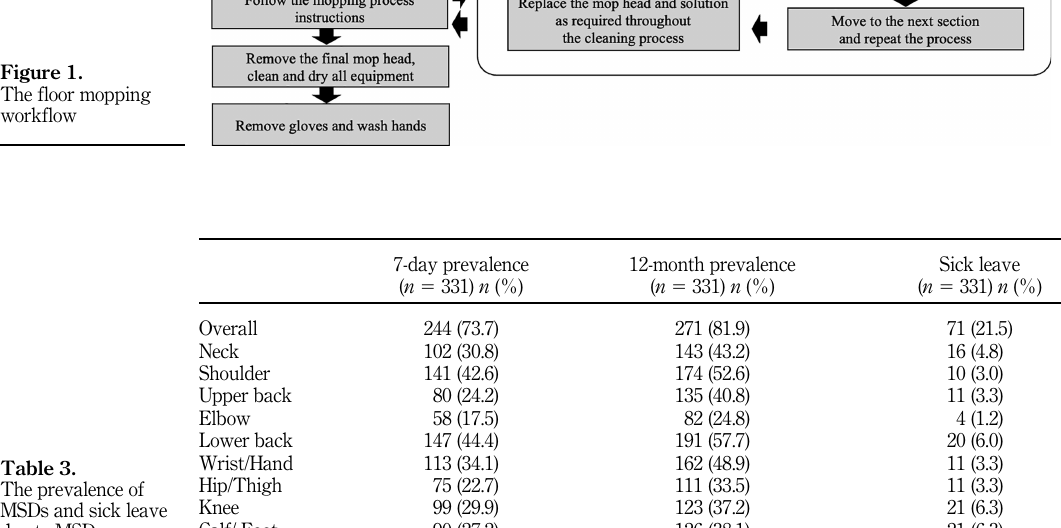
Table 3. The prevalence of MSDs and sick leave due to